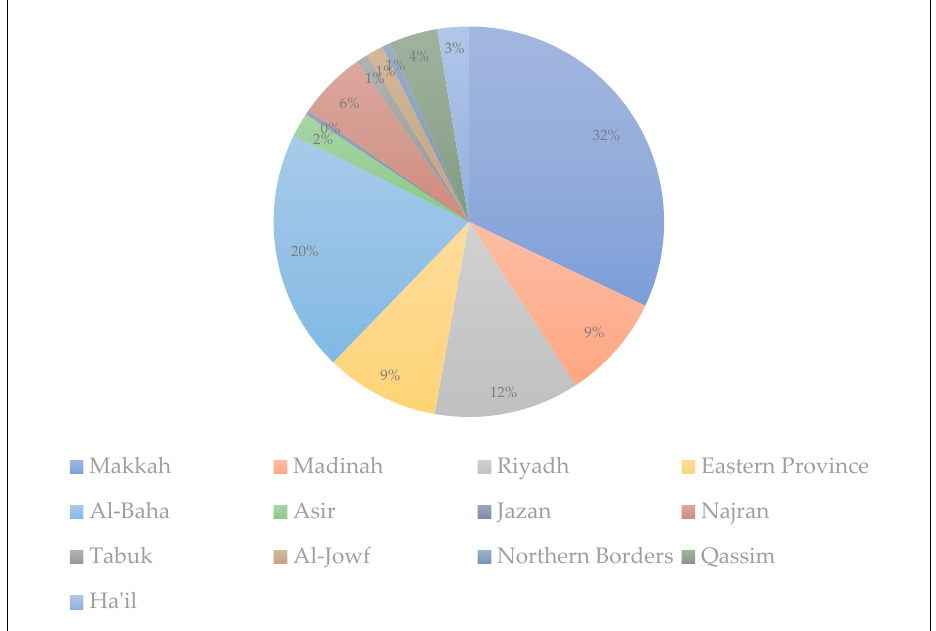
Figure 2. Response percentage according to the regions.